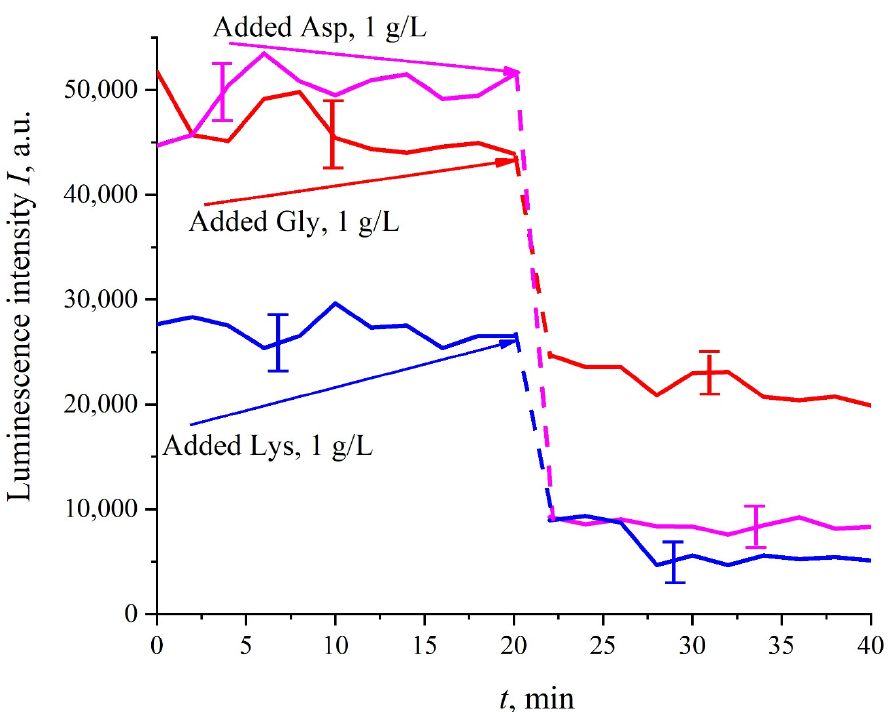
Figure 5. Dependence of the luminescence intensity from the colloidal mixture of Nafion particles at adding amino-acid suspensions (20-th minute). The dependences for aspartic acid, glycine and lysine with a concentration of 1 g/L are given.